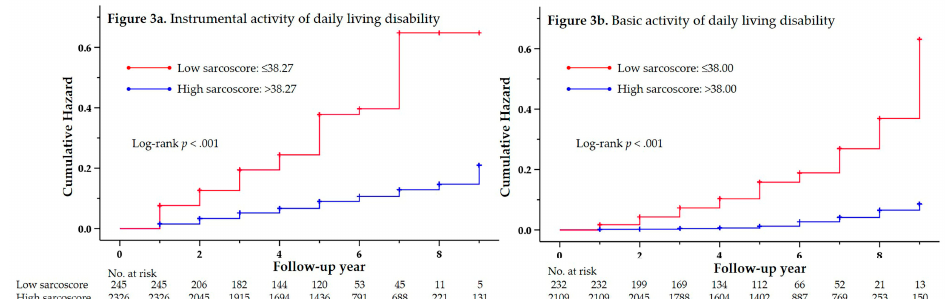
Figure 3. Cumulative risk of disabilities in instrumental and basic activities of daily living according to the sarcoscore criteria. The sarcoscore criteria was set so that the sarcopenia prevalence would be similar to that of the sarcopenia prevalence based on the AWGS criteria. BADL, basic activities of daily living; IADL, instrumental activities of daily living.